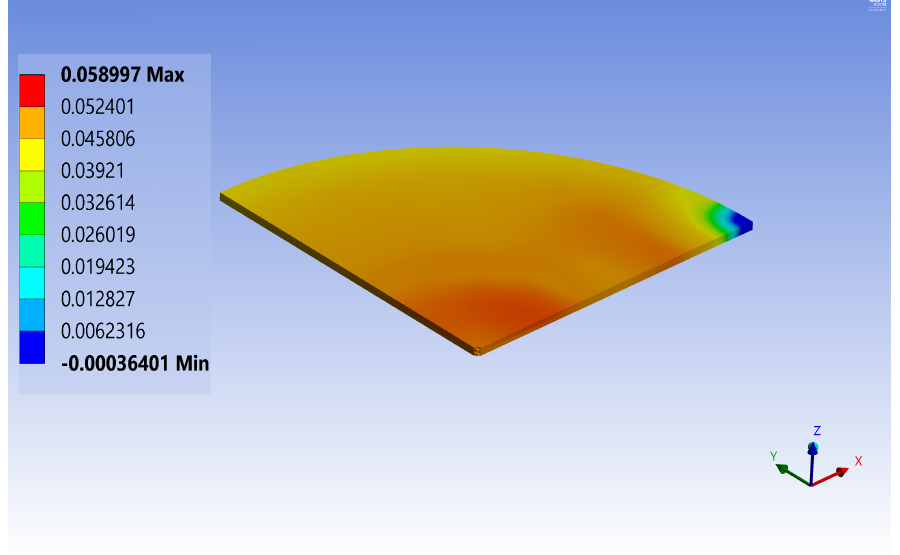
Figure 8. Numerical simulation: out-of-plane deflection (in mm) after glass frit bonding for